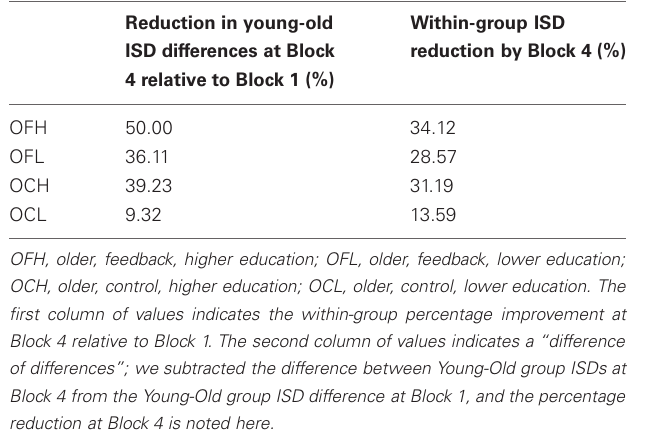
Table 2 | Proportionate improvements in ISDs for older